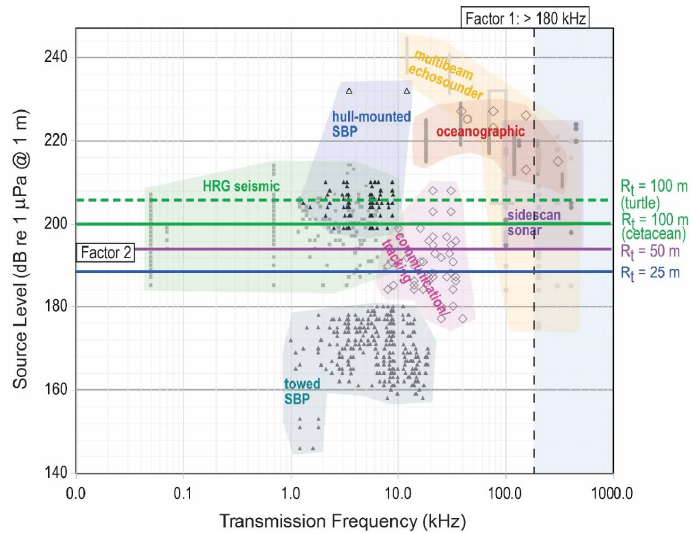
Figure 5. Data from Figure 4A are shown grouped for each class of non-airgun sources along with two factors that render some of these sources de minimis . Factor 1 is indicated by the vertical line at 180 kHz transmission frequency, indicating that sources with higher transmission frequency are de minimis . The horizontal blue, purple, green (all for cetacean criterion of received SPL of 160 dB re 1 μPa for incidental take and various densities from Figure 6), and green dashed (turtle criterion; received SPL of 166 dB re 1 μPa) lines correspond to adjusted SL ( SL it ) calculated for the indicated threshold radii R t . These are generalized values, but SL it can be calculated for the known density of a given marine species (Figures 6 and 7). The calculations assume spherical spreading, which is valid even for very shallow water depths for the frequencies of many HRG sources. NMFS has pre- viously adopted 25 m (85 FR 14903 [64]; R t = 25 m and SL it = 188 dB re 1 μPa) in our formulation) as the zone around a source where SPL might exceed 160 dB re 1 μPa without leading to incidental take.